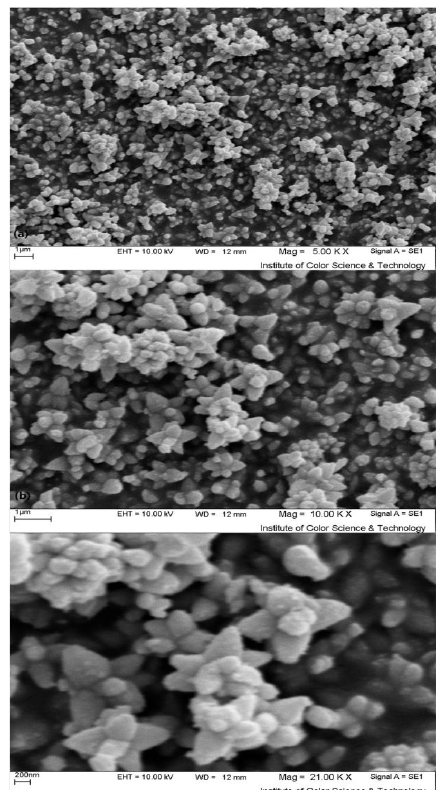
Fig. 2. XRD patterns of ZnS/ZnO nanoparticles Fig. 3. SEM images of ZnS nanoparticles by